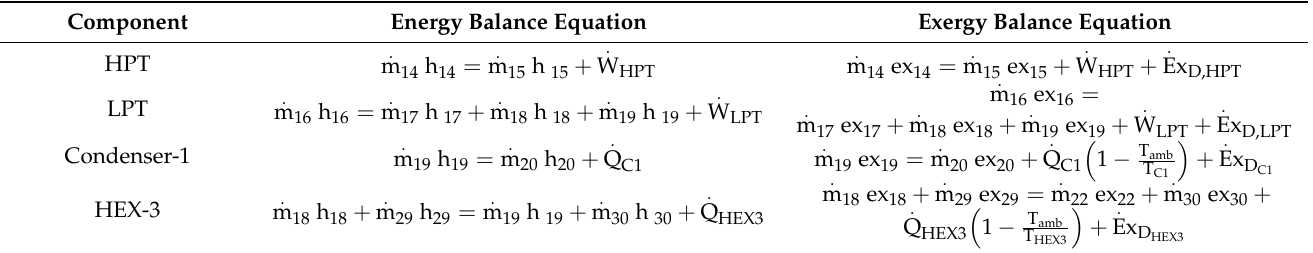
Table 2. Thermodynamic balance equalities of multi-generation system